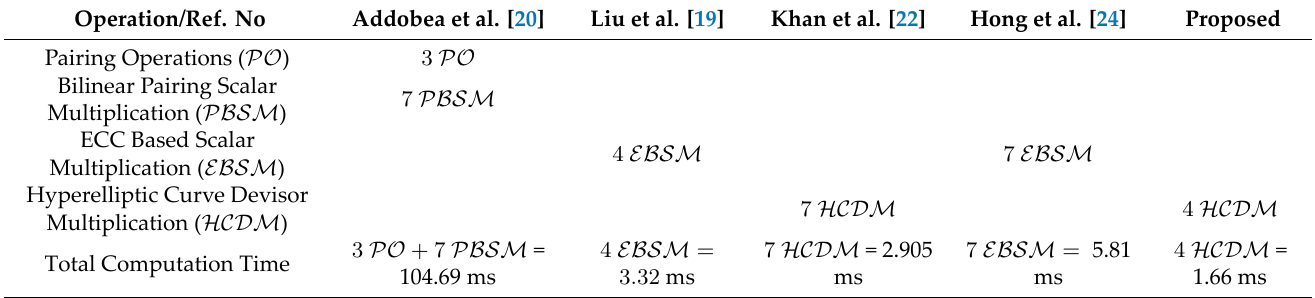
Table 6. Total computation costs of both the online and offline phases.